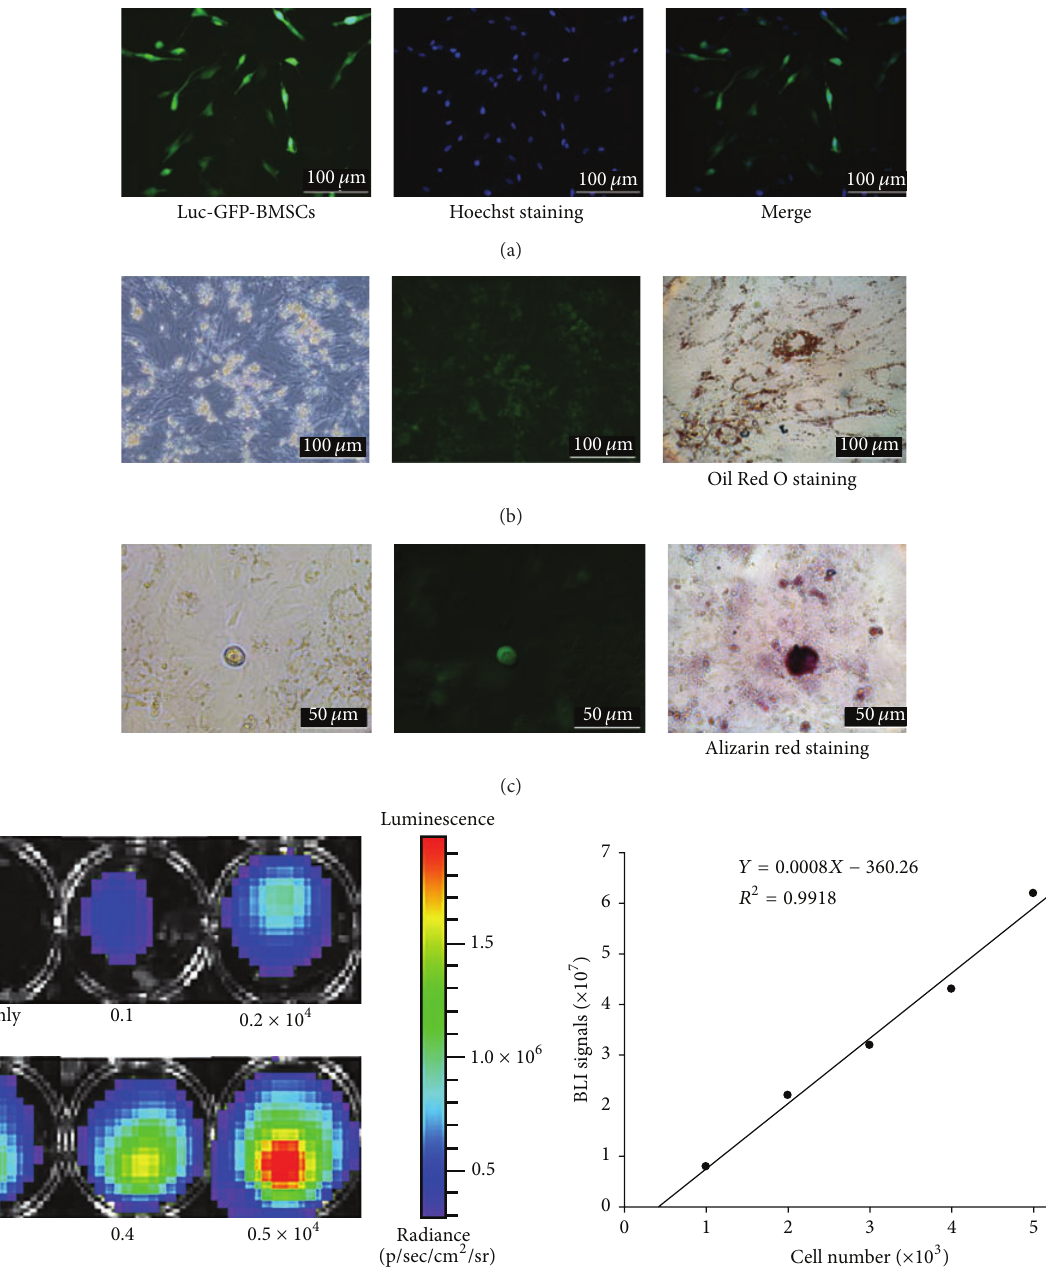
Figure 1: Characterization of rats treated with Luc-GFP-BMSCs. (a) GFP expression in Luc-GFP-BMSCs. The transduction efficiency was estimated by comparing the number of GFP-positive cells with the total cells via Hoechst staining. (b and c) The capability of Luc-GFP-BMSCs to differentiate according to an adipocyte or osteopenia pattern was verified by staining with Oil Red O and Alizarin red, respectively. After adipocyte and osteopenia differentiation, the cells still express GFP. (d) BLI of varying numbers of Luc-GFP-BMSCs in vitro . Representative images of at least three independent experiments. (e) Quantitative analysis revealed a strong linear relationship between cell numbers and the BLI signal ( 𝑅 2 = 0.9918